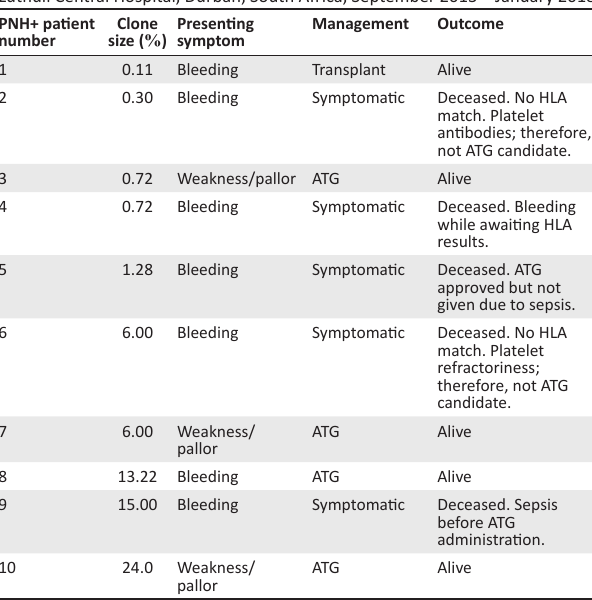
PNH+, paroxysmal nocturnal haemoglobinuria population-positive; ATG, antithymocyte globulin; HLA, human leukocyte antigen.